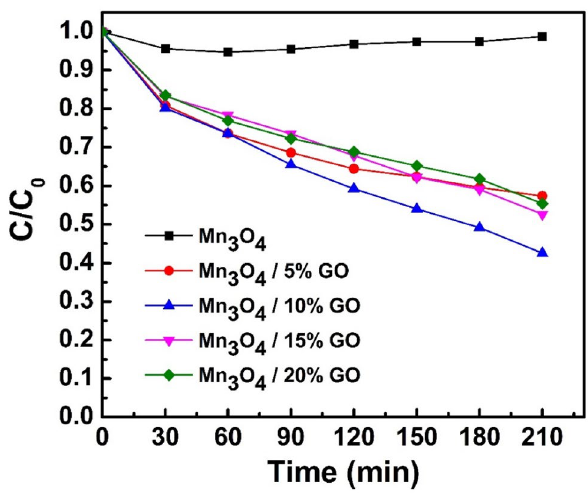
Fig. 11 Normalized concentration of MB solution for photocatalytic degradation by the Mn 20)